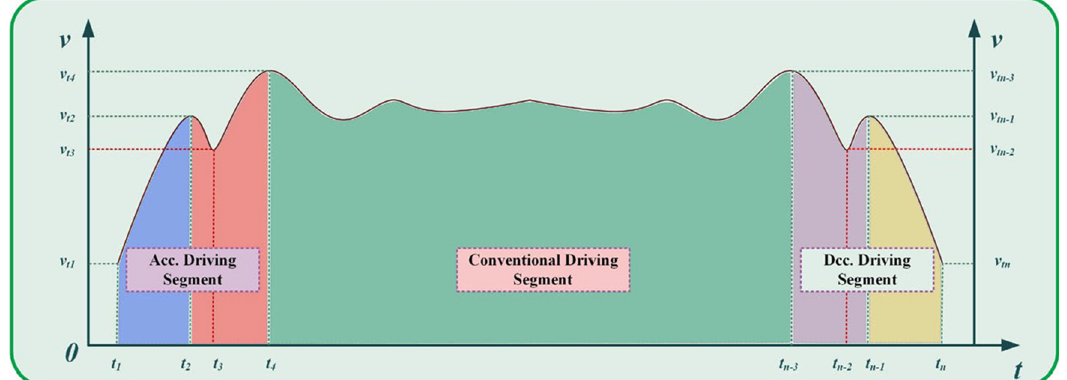
Figure 7 Schematic diagram of acceleration and deceleration segment